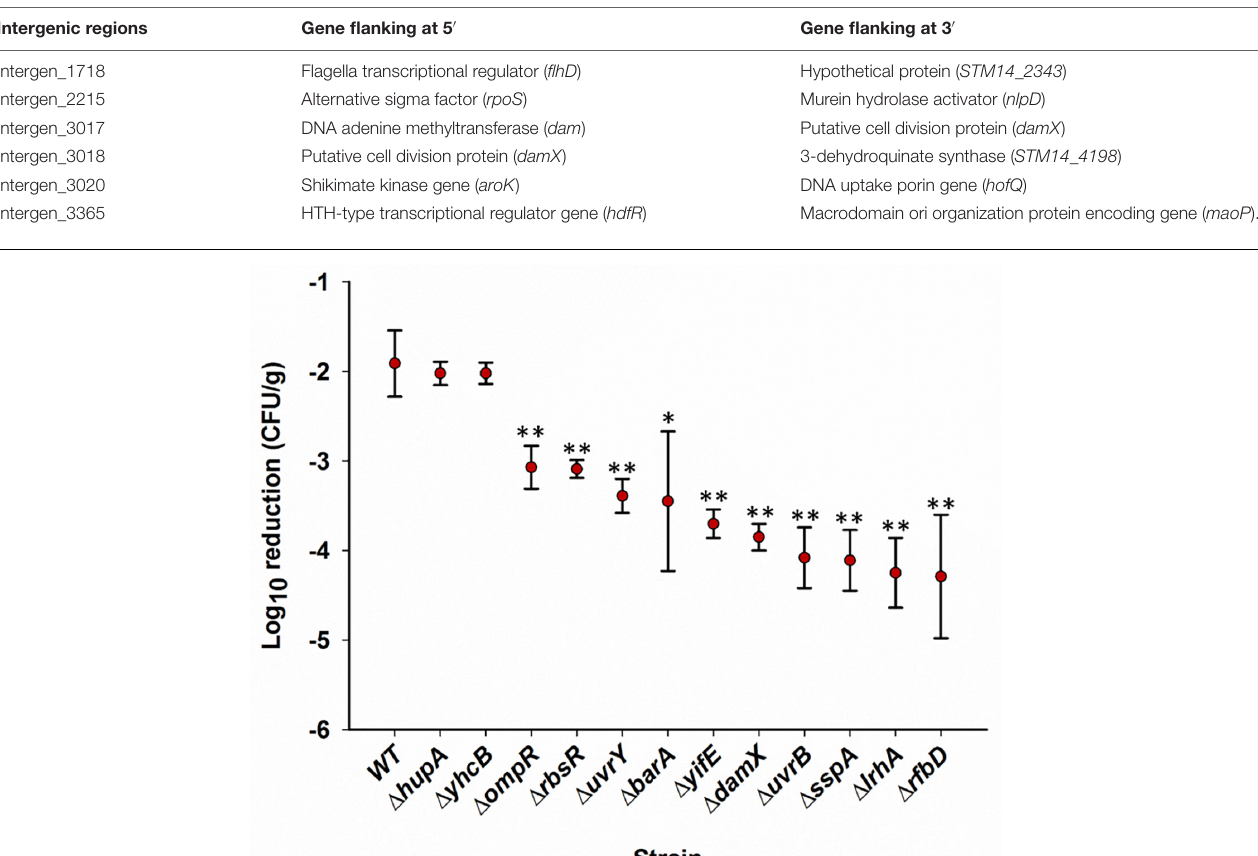
TABLE 2 | Genes flanking the six intergenic regions under selection in Salmonella on pistachios.